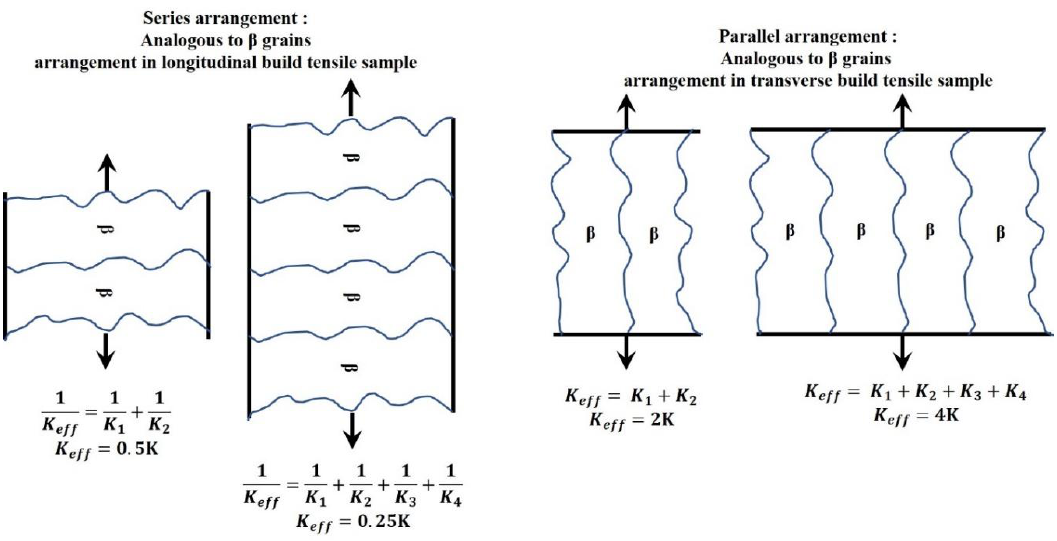
Figure 3. Hall–Petch relationship between α lath size and yield strength for as-built and heat-treated samples.